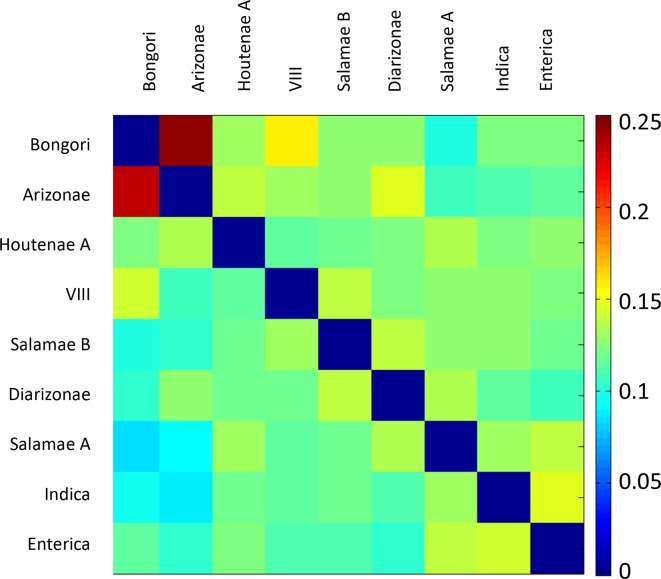
Coancestry matrix between nine unrelated genomes, computed using ChromoPainter. Each cell of the coancestry matrix is coloured according to the amount of genetic material copied from a donor genome (columns) to a recipient genome (rows).